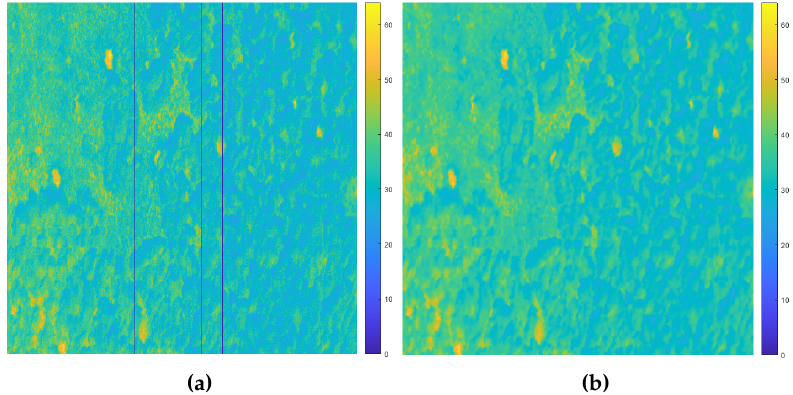
Figure 5. False colour representation of an ROI image in radiance during the pre-processing stage. ( a ) Raw image at 415 nm wavelength band. ( b ) Resultant filtered